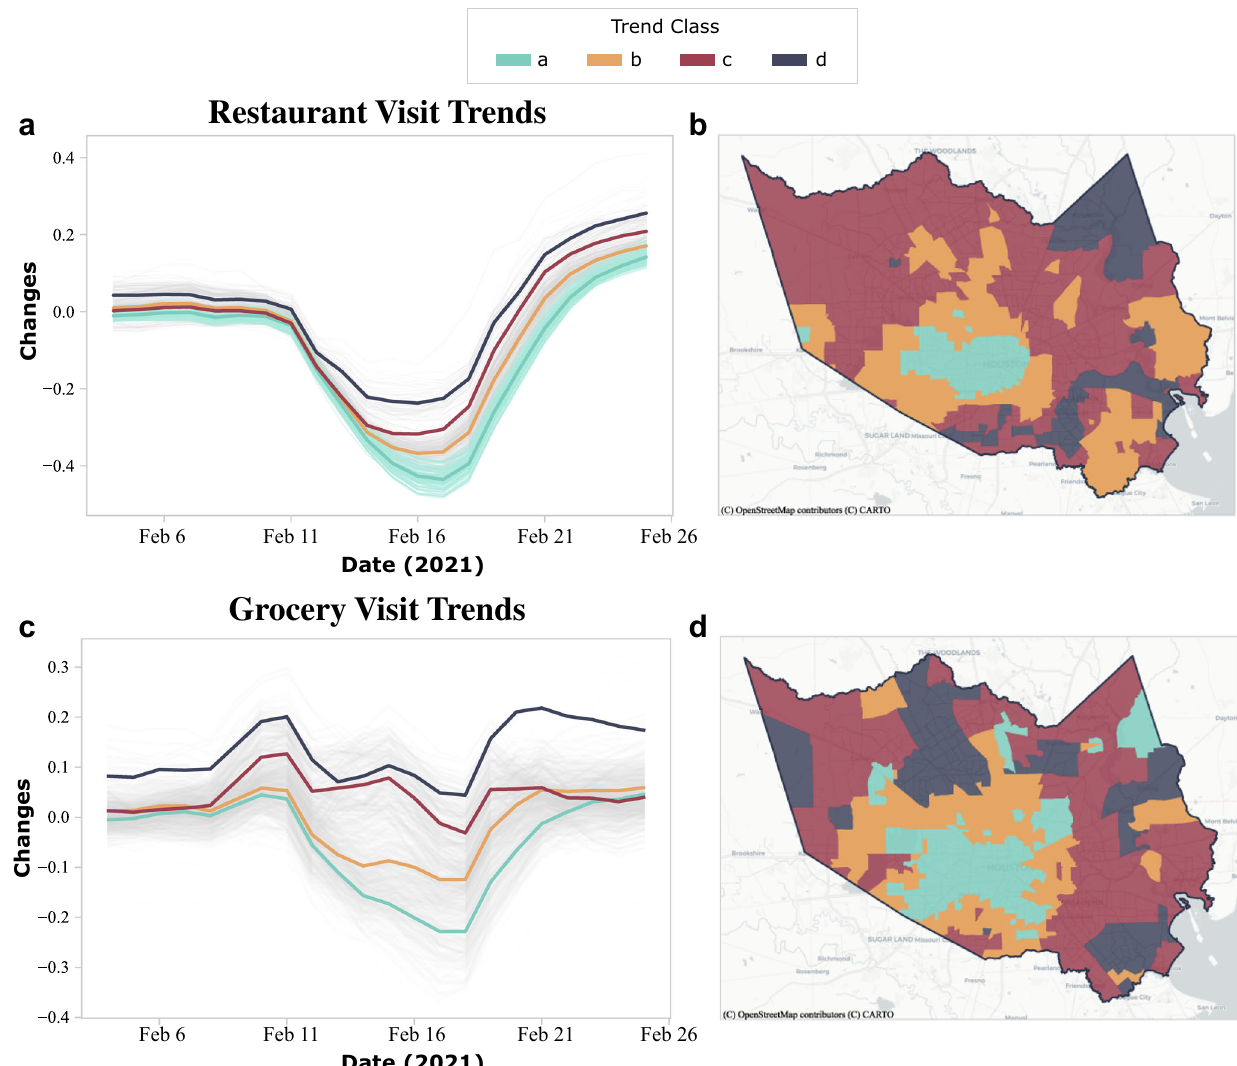
Fig. 9 Spatiotemporal distribution of the restaurant and grocery store visits in Harris County. The results of the restaurant visits are shown in a and b , and the results of grocery store visits are shown in c and d . Four classes, from Class a through Class d , represent four patterns of visit trends from the most impacted class to the least impacted class, respectively. Trend line is the average of a group of census tracts having similar patterns and represents the visit fl uctuations of these census tracts. The most impacted areas (Class a ) of the restaurant and grocery store visits are close to Houston ’ s downtown